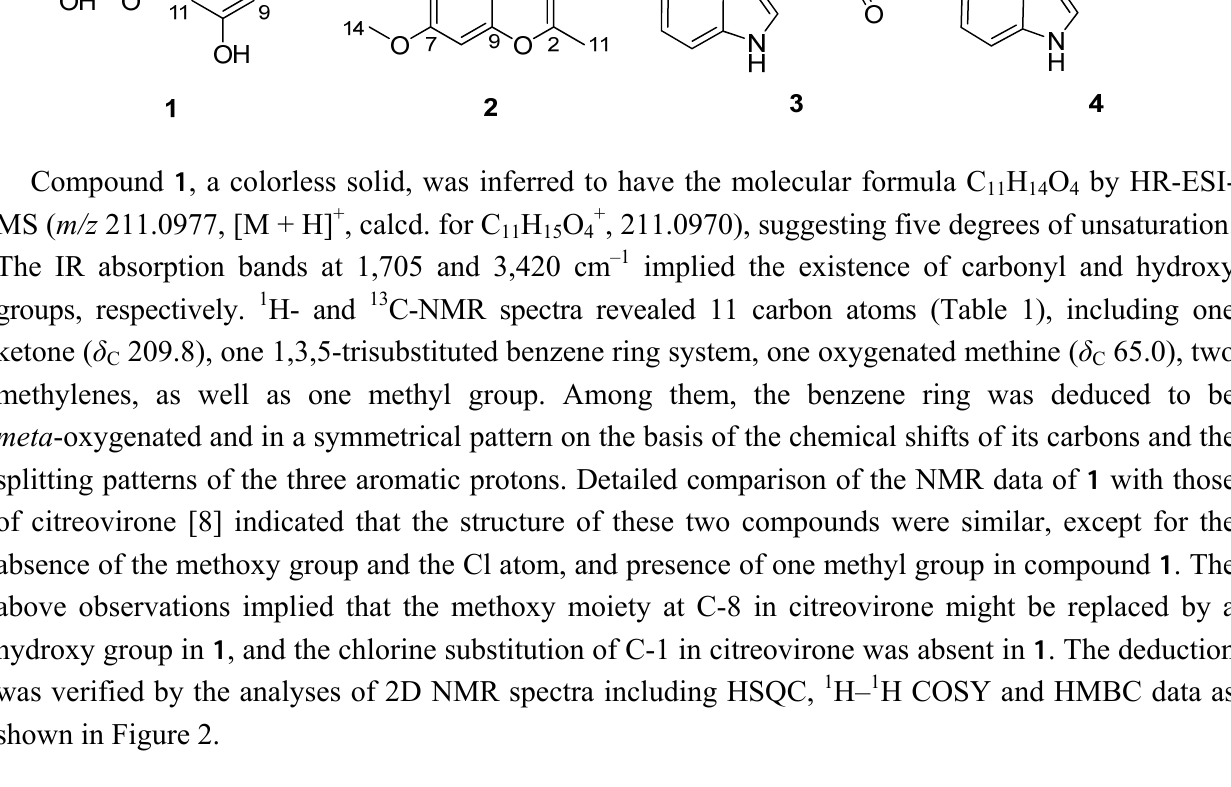
Figure 2. 1 H– 1 H COSY (bold) and HMBC (arrow, H → C) correlations of compounds 1 and 2